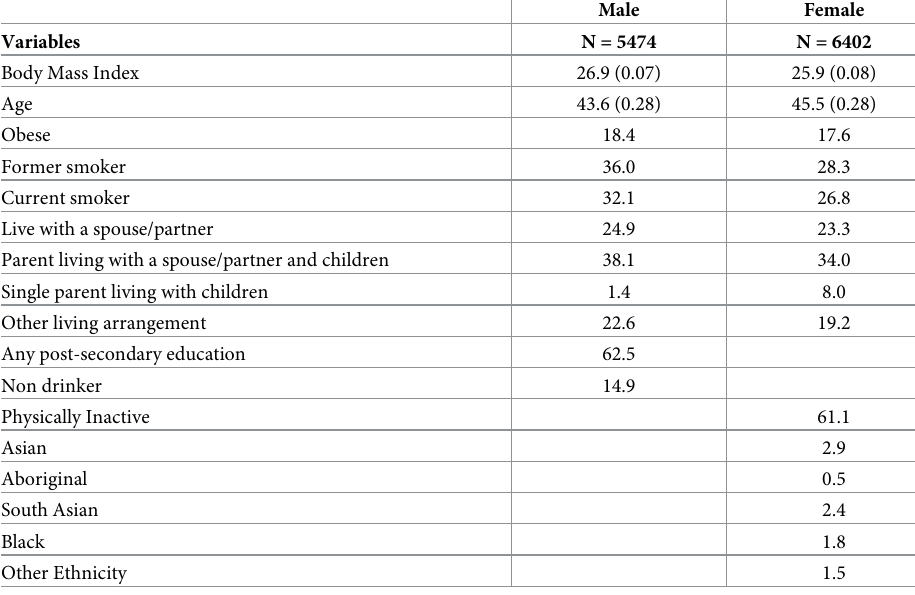
Table 1. Descriptive characteristics of the cohort at